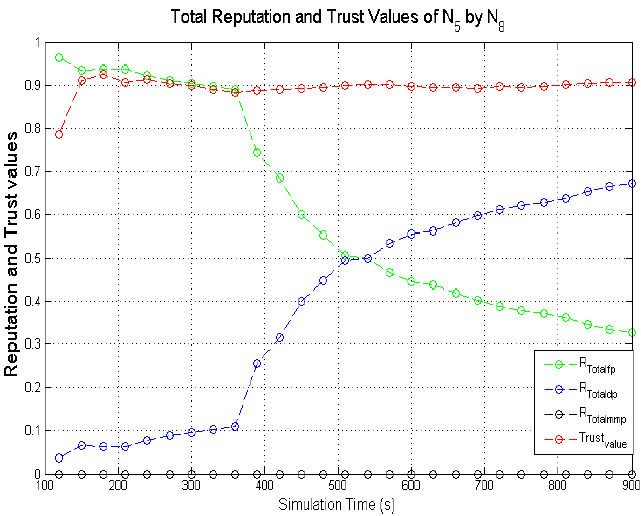
Figure 21. N 5 is low energy-constrained selfish and honest, N 8 is benevolent and honest.